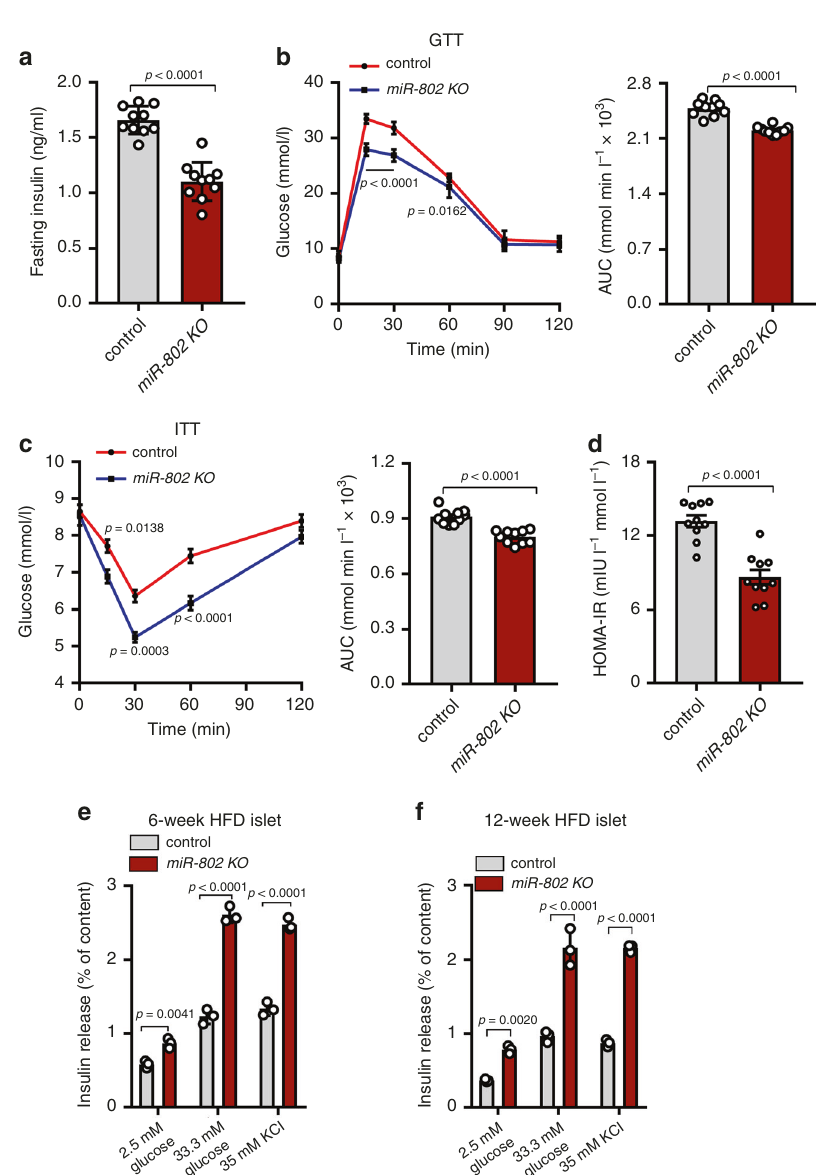
Fig. 5 miR-802 KO mice improves obesity-associated insulin resistance and glucose intolerance when fed with high fat diet (HFD). 8-week-old male miR-802 KO mice and control mice ( miR-802 fl / fl ) were exposed to HFD for 12 weeks. a Then, Fasting insulin levels (FINS) of HFD-fed mice were measured by ELISA after 12-week of feeding HFD ( n = 10). ( b , c ) Intraperitoneal glucose tolerance test (GTT) (1.5 g kg − 1 ) ( b ) and intraperitoneal insulin tolerance test (ITT; 0.75 U kg − 1 ) ( c ) were performed in miR-802 KO mice and control mice at the 11th or 12th week of High fat diet administered, respectively. The corresponding area under the curve (AUC) of blood glucose level was calculated ( n = 10). d Homeostatic model assessment indices of insulin resistance (HOMA-IR) of miR-802 KO mice and control mice ( n = 10). e , f Insulin release from islets of miR-802 KO mice or control mice after 6-week ( e ) or 12-week ( f ) HFD treatment ( n = 5). The p -values by two-tailed unpaired Student ’ s t test ( a , d ), or two-way ANOVA ( b , c , e , f ) are indicated. In all panels error bars indicate mean ± SEM, except ( e , f ) (mean ± SD). Source data are provided as a Source Data fi le.